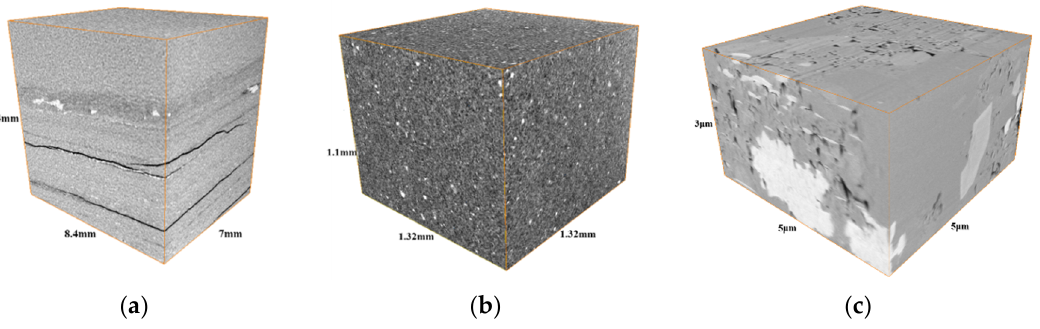
Figure 2. Micro-CT and FIB-SEM scanning image with different resolutions: ( a ) microfracture sample; ( b ) micropore subsample; and ( c ) nanopore subsample.